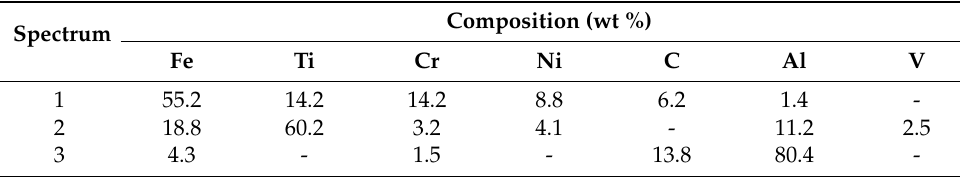
Table 5. EDX analysis results of the SS/Al IMC layer from sample